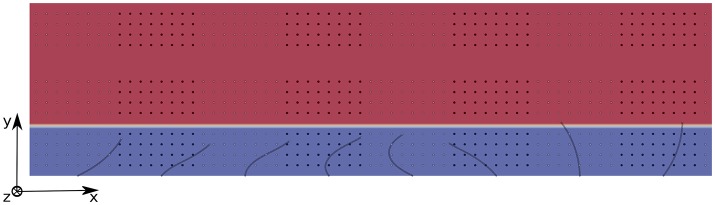
2D view of the domain filled with 3 populations of tracers for Re = 5.10−2. The PCL is blue, and the mucus phase is red. Population 1 occupies the PCL between z = 0.2L and z = 0.8L; Population 2 is located above the PCL-mucus interface and occupies the region between z = 1.2L and z = 1.8L; Population 3 is located far above the PCL-mucus interface, and occupies the region between z = 2.5L and z = 3.1L. The size of the computational domain is (Nx = 385, Ny = 11, Nz = 34).